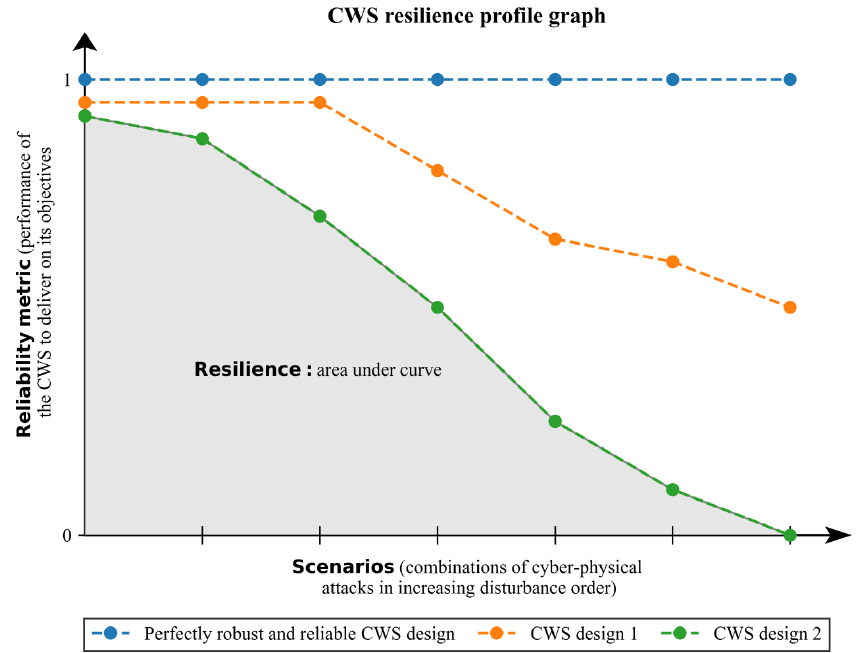
Figure 1. CWS resilience profile graphs.